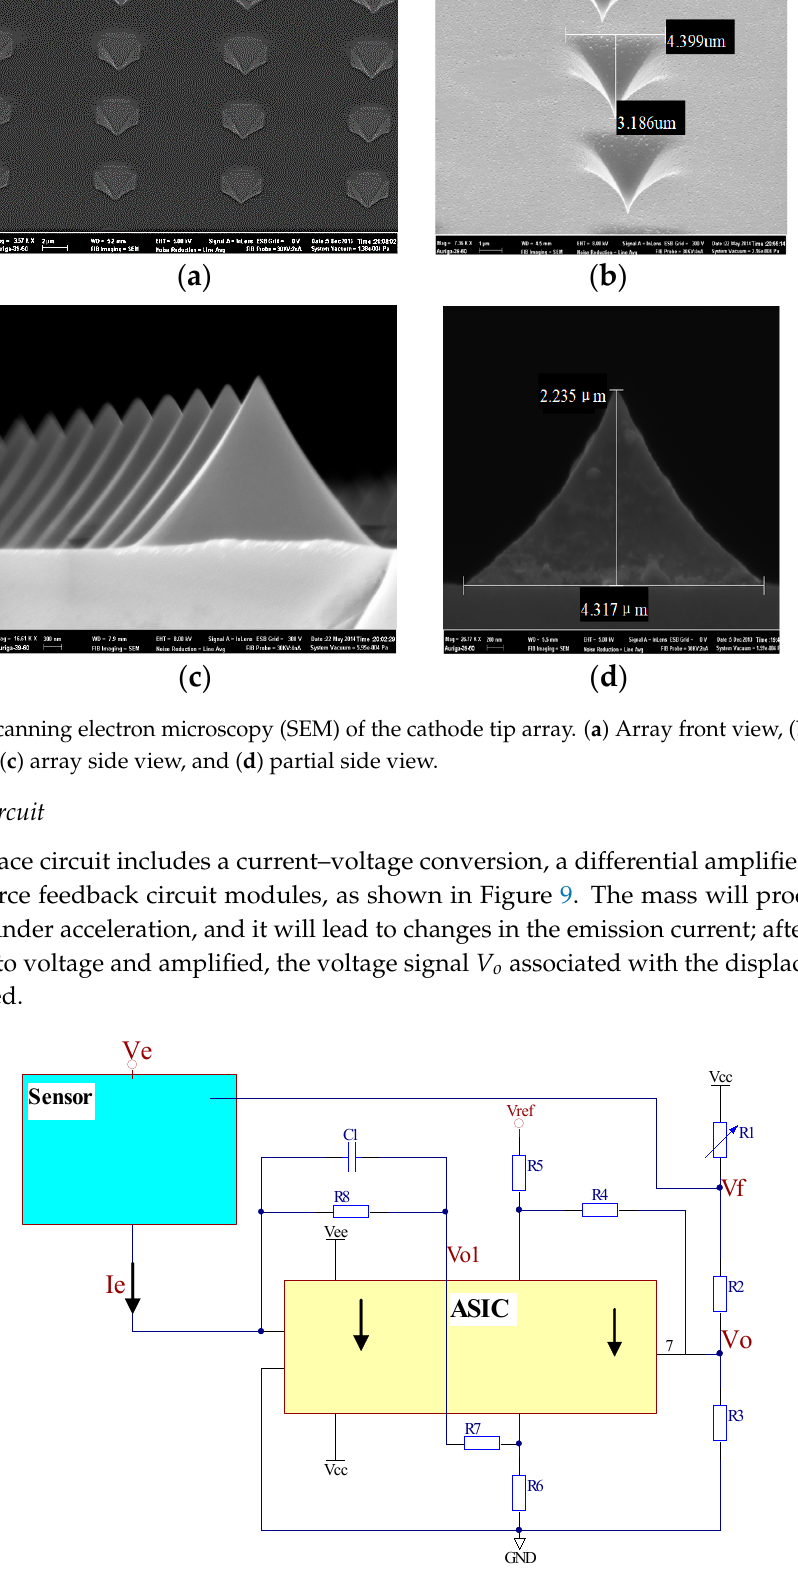
Figure 9. Schematic of the interface circuit of the vacuum microelectronic accelerometer. The transmission current of the cone is exponentially related to the change of the displacement. When the displacement change is very small, the current can be approximated linearly. The voltage after the I – V conversion is calculated by Equation (4): 𝑉 (cid:3042)(cid:2869) = 𝑅 (cid:2876) ∙ 𝐼 (cid:3032) (1 − 𝛼∆𝑥)